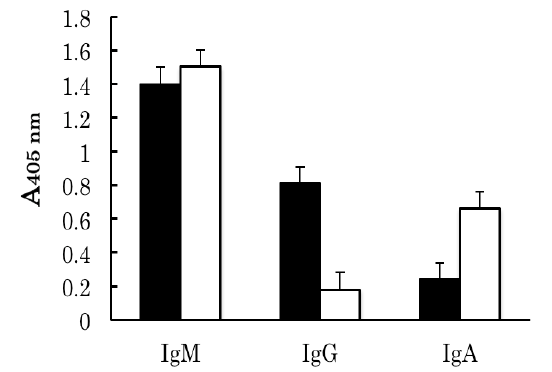
Figure 2. Binding of human anti-ferritin autoantibodies (IgM, IgG and IgA) to the expressed recombinant human H and L subunit homopolymers. After complex formation between partially purified FBPs with the recombinant human ferritin H (solid bar) or L (open bar) subunit homopolymers, specific antibodies to human ferritin H and L subunits were added to precipitate H and L subunit homopolymeres, respectively. Detection of immunoglobulins (IgM, IgG and IgA) was carried out as described in Figure 1. Control reactions without human FBPs were carried out for each antibody class and subtracted from the reaction values. Each bar and error bar represents the mean ± SD of four